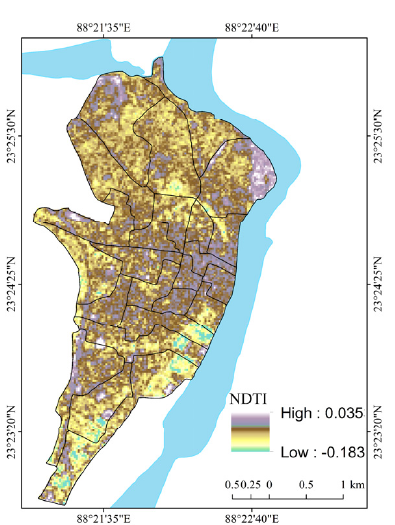
Figure 41. Distance of the centers of the municipal wards from the old river course (2015). Figure 42. Distance of the centers of the municipal wards from the new river course (2015).